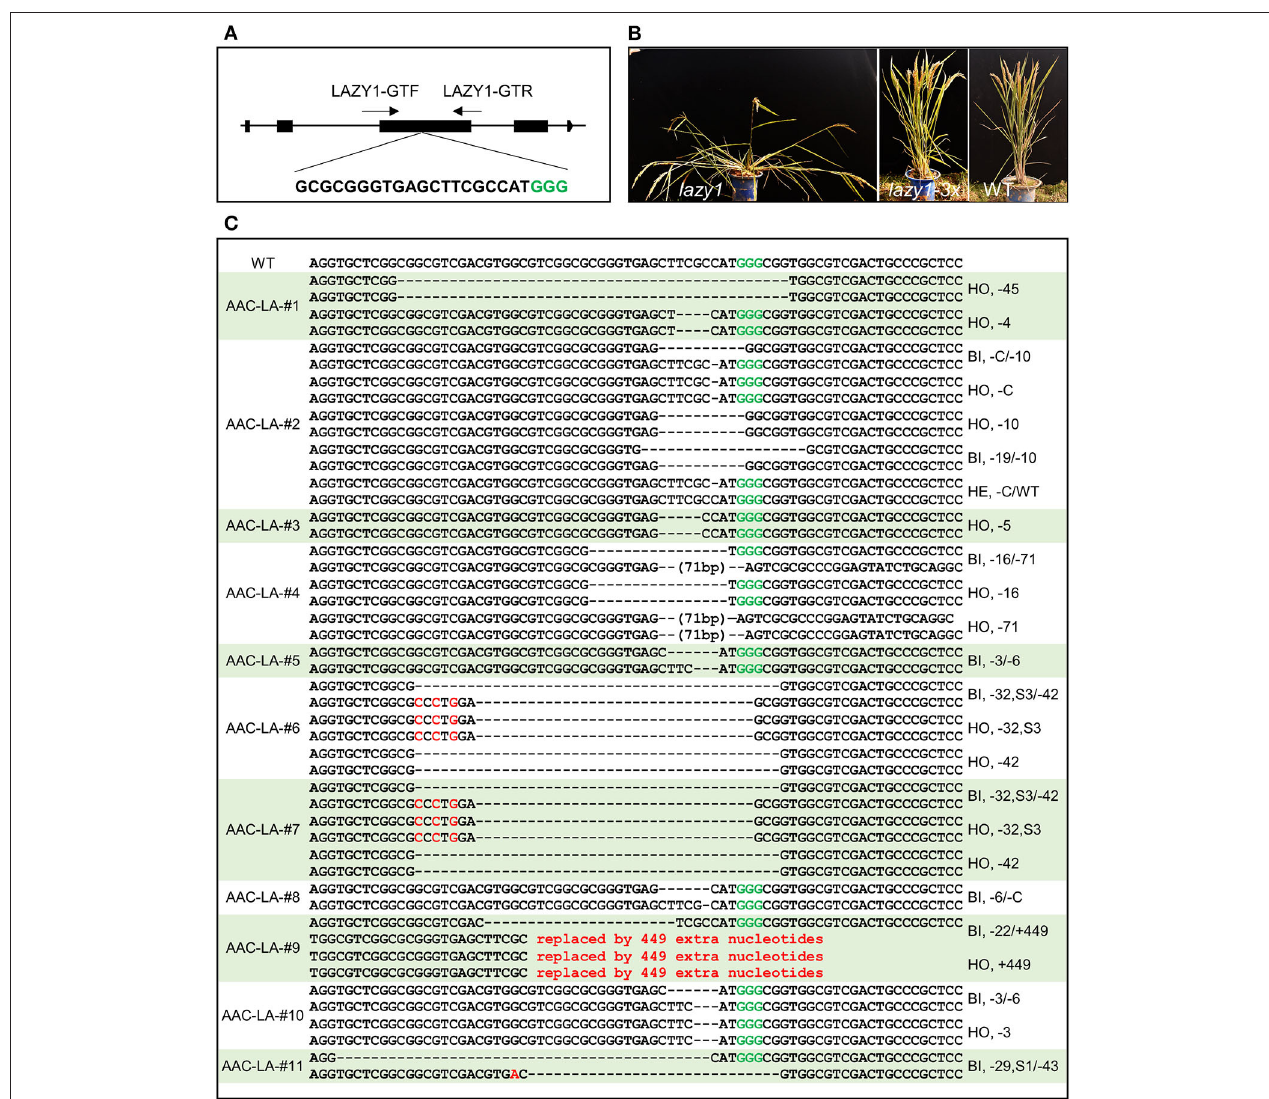
FIGURE 4 | Identification of transgene-free and target gene-edited lazy1 mutants. (A) Target site of LAZY1 used in AAC-LA . A target sequence in the LAZY1 gene includes the PAM site GGG (marked green) is shown. LAZY1-GTF and LAZY1-GTR were the genotyping primer pair of LAZY1 CRISPR plants. Primers were listed in Supplementary Table 3 . (B) Loss-of-function lazy1 mutants displayed an obvious tiller angle phenotype. WT, lazy1 and lazy1-3x refer to wild type, loss-of-function lazy1 mutant, and in-frame (multiple of three base pairs deletion) lazy1 mutant plants, respectively. (C) The mutation forms of the transgene-free and CRISPR-edited lazy1 mutants. The PAM site “GGG” in green required for Cas9 cleavage is marked in green. “WT” refers to the wild type plants. “HO,” “HE,” and “BI” represent homozygous, heterozygous, and bi-allelic genotypes, respectively. “-” refers to a deletion of one base pair. “S3” and “S1” means three and one base pair(s) substitution,